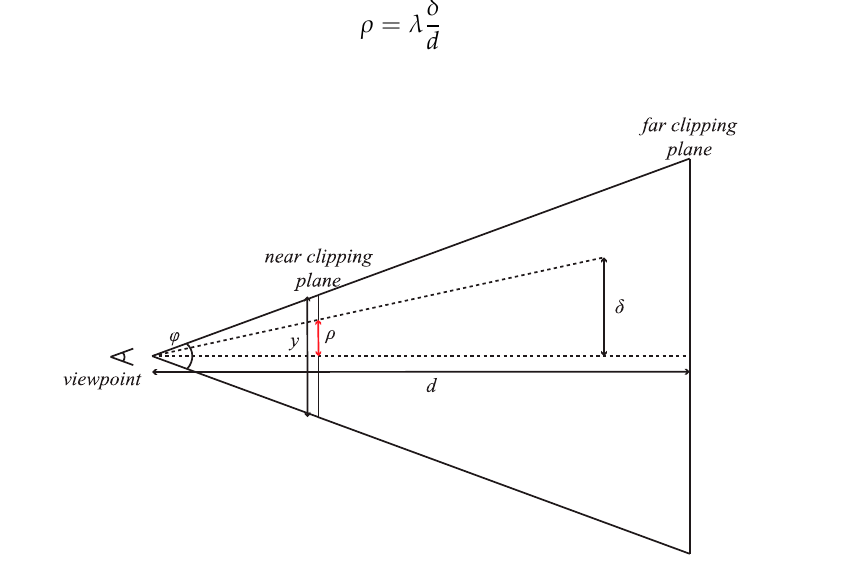
Figure 9. Computation of screen-space error 𝜌 .